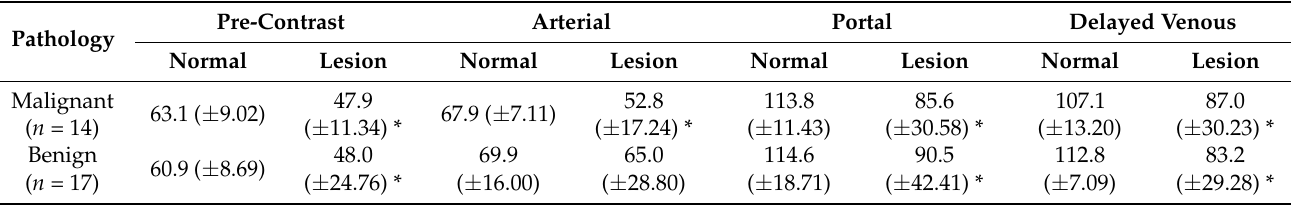
Table 1. Mean ( ± SD) attenuation values (HU) of the normal liver parenchyma and the lesion of the malignant and benign pathologies in the different phases of TP-MDCT.